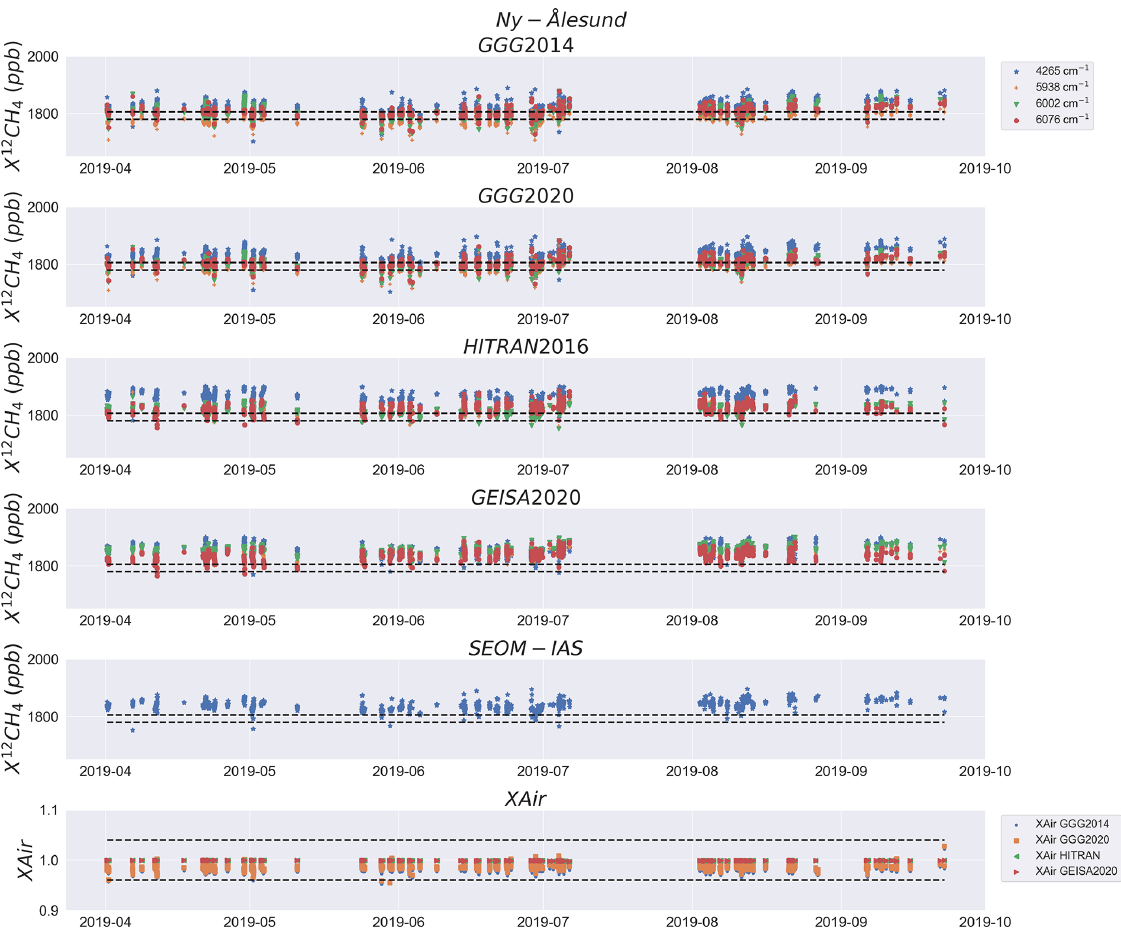
Figure 4. Retrieval time series for 12 CH 4 DMFs from the Ny-Ålesund site. Each panel indicates retrievals from each spectral window (indicated in the legend) from a specific spectroscopic database, indicated in the panel title. Blue stars show retrievals from band 1; yellow pluses are band 2; green triangles are band 3; red circles are band 4. The standard deviations about the reference TCCON retrievals are indicated by the horizontal dashed lines. The bottom panel indicates the retrieved XAir DMF as a quality indicator for the retrievals, with the dashed lines indicating the standard range of acceptable XAir values. The date format is